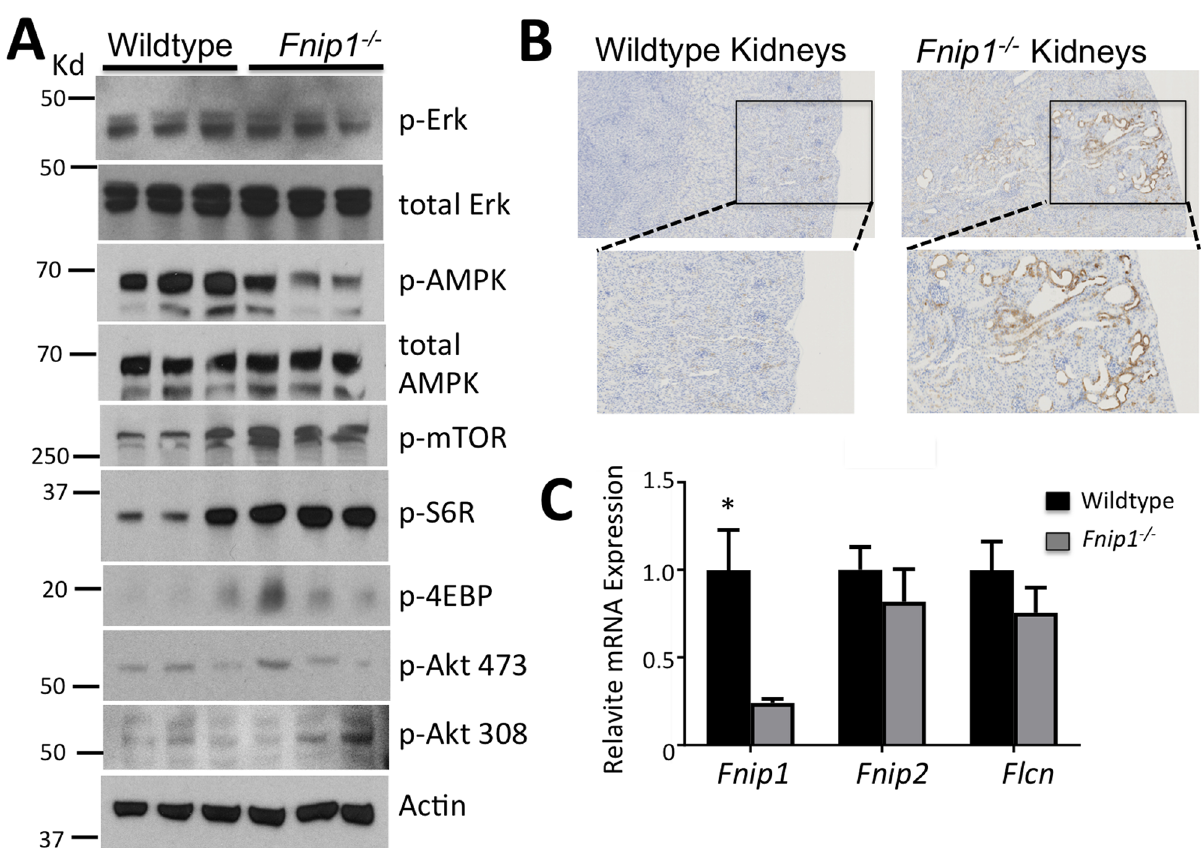
Fig 2. Increased mTOR and decreased AMPK activation in Fnip1 null kidney tissue and renal tubular epithelial cells. (A) Representative immunoblots showing decreased AMPK activation (pAMPKThr172) and increased mTORC1 activation (p-S6R, p-4EBP1) in total renal tissue from Fnip1 -/- and WT mice. Statistical quantitation is shown in S1 Fig. n = 3 mice per genotype (each lane). (B) Representative immunohistochemistry images showing increased p-S6R activation around cystic tubules in Fnip1 -/- mice. Representative of 3 mice per genotype. (C) Real-time quantitative PCR showing no significant changes in expression of Flcn (Bhd) and Fnip2 mRNA in Fnip1 -/- renal tissue versus WT (n = 3/genotype, (cid:3) = p = 0.03). Mice used were between 12–18 weeks of age.